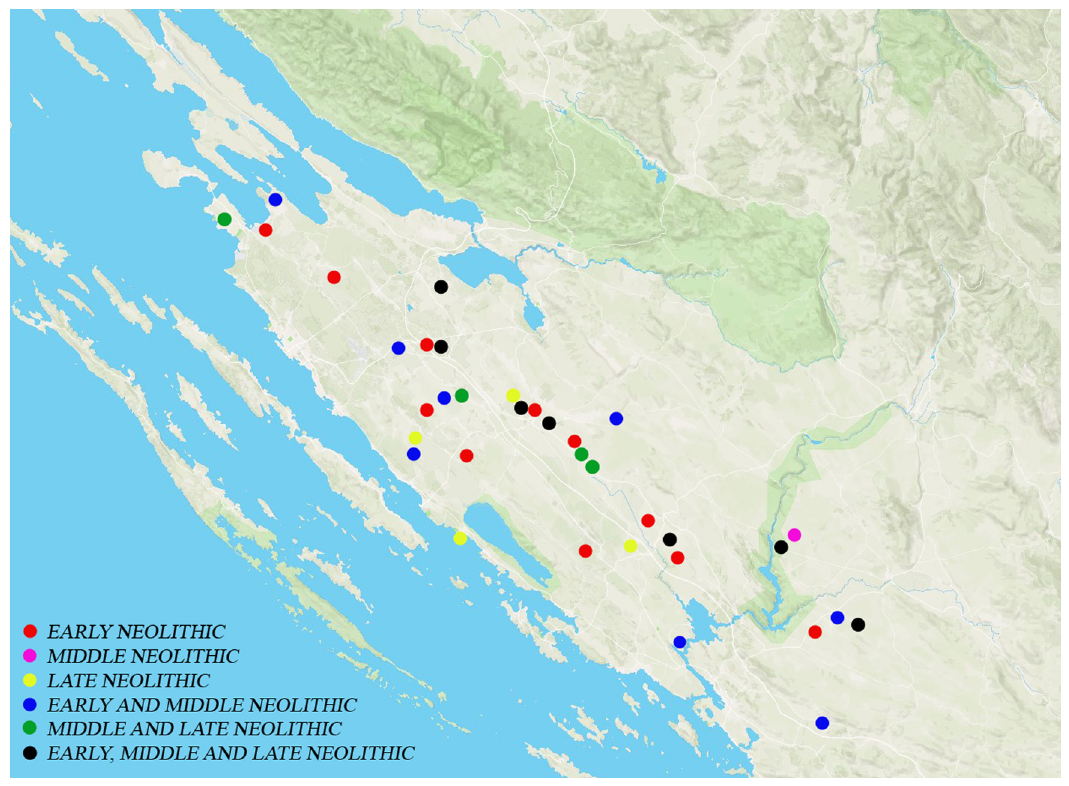
Figure 4: List of sites and phases ( drawing: K. Horvat )